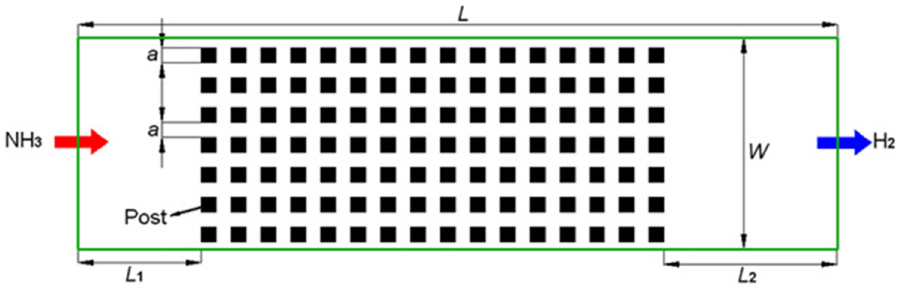
Figure 3. Structures of the post microreactor [20].